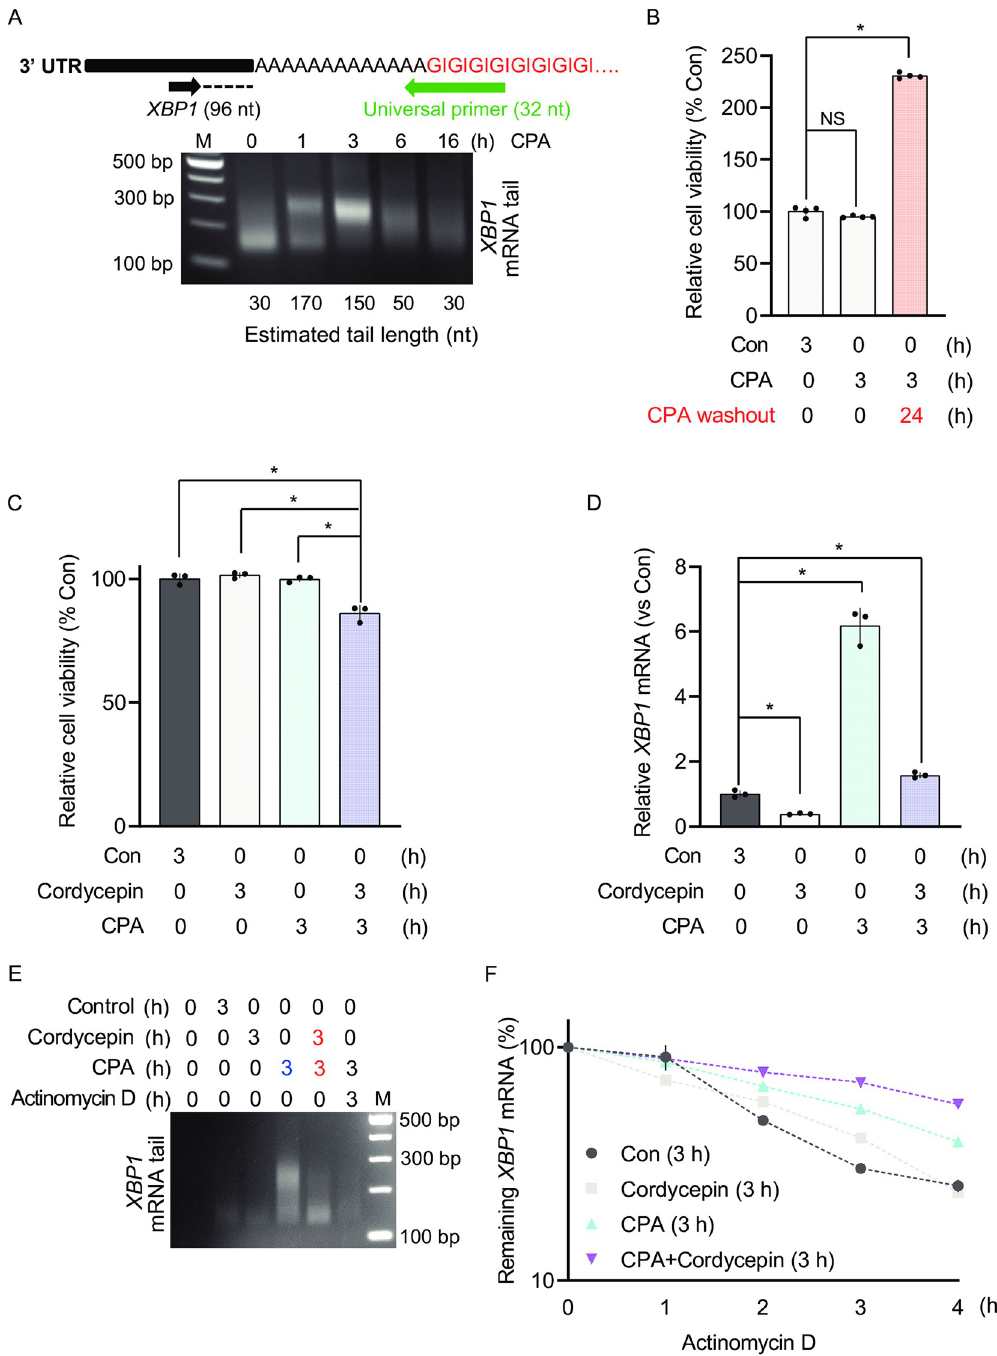
Fig 4. Polyadenylation of newly synthesized RNA during acute ER stress promotes cell survival. (A) MEFs were treated with CPA for the indicated durations. Following RNA isolation and the PCR-based poly(A) tailing assay, the poly(A) tail length of XBP1 mRNA was measured in the indicated treatments. (B) MEFs were treated with DMSO (Con) or CPA (100 uM) for 3 h and cell viability was measured. Following CPA treatment, cells were allowed to recover in fresh media in the absence of CPA for 24 h past the 3 h treatment of CPA. (C) Cell survival was assayed in MEFs treated with DMSO (Con), CPA, 10 μ g/ ml cordycepin, or combined CPA and cordycepin for 3 h. (D) RT-qPCR analysis of XBP1 mRNA levels in MEFs treated with DMSO (Con), CPA, cordycepin, or combined treatment of CPA and cordycepin for 3 h. (E) MEFs were treated with DMSO (Con), CPA, cordycepin, or combined treatment of CPA with either cordycepin or Actinomycin D for 3 h. XBP1 mRNA poly (A) tail length was measured using the PCR-based poly(A) tailing assay. (F) Cells were treated with DMSO (Con), CPA,